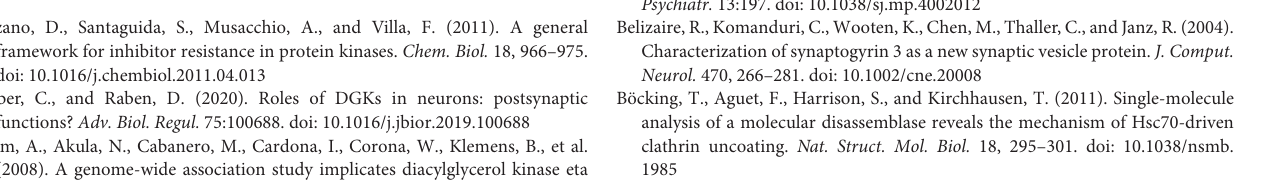
Supplementary Figure 2 | Basp1, cofilin-1, PKC α , SNAP-25, and synaptojanin-1 were not detected in our streptavidin pulldown experiments and therefore we were